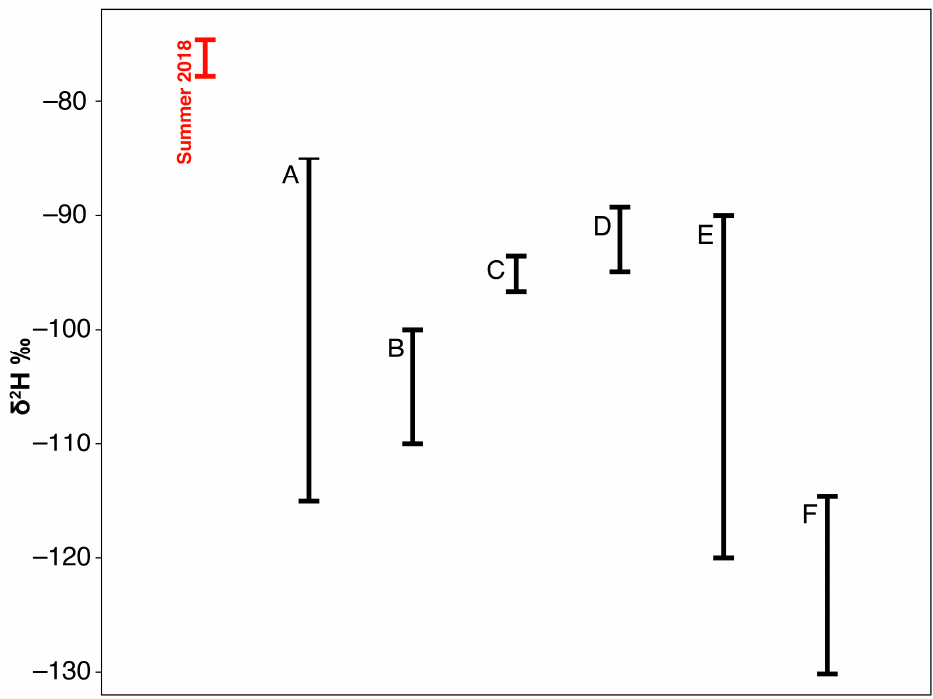
Figure 7. δ 2 H range of alpine periglacial waters in the summer of 2018 described in this study, compared with alpine stream waters from other glacial areas reported in previous studies: A = Vauz surface waters [25], B = Saldur surface waters [32], C = Adige river source waters [27,42], D = Vermigliana surface waters [73], E = Noce Bianco surface waters, and F = Swiss surface waters [74].